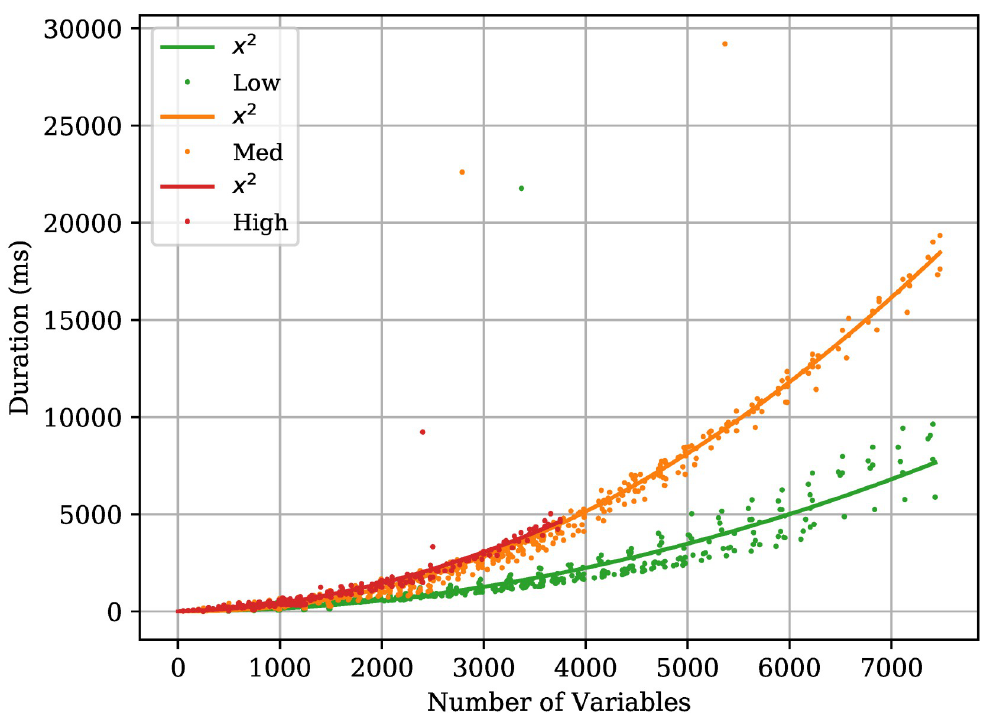
Fig 5. Time needed for LP to solve the PC-MFMC. Time taken for the LP algorithm to find a solution to the PC-MFMC problem as the number of variables is increased, grouped by the network load. x 2 plot refers to the degree 2 polynomial generated when fitting a curve to the generated data points. The Low, Med, High legend labels refer to the different network loads used.